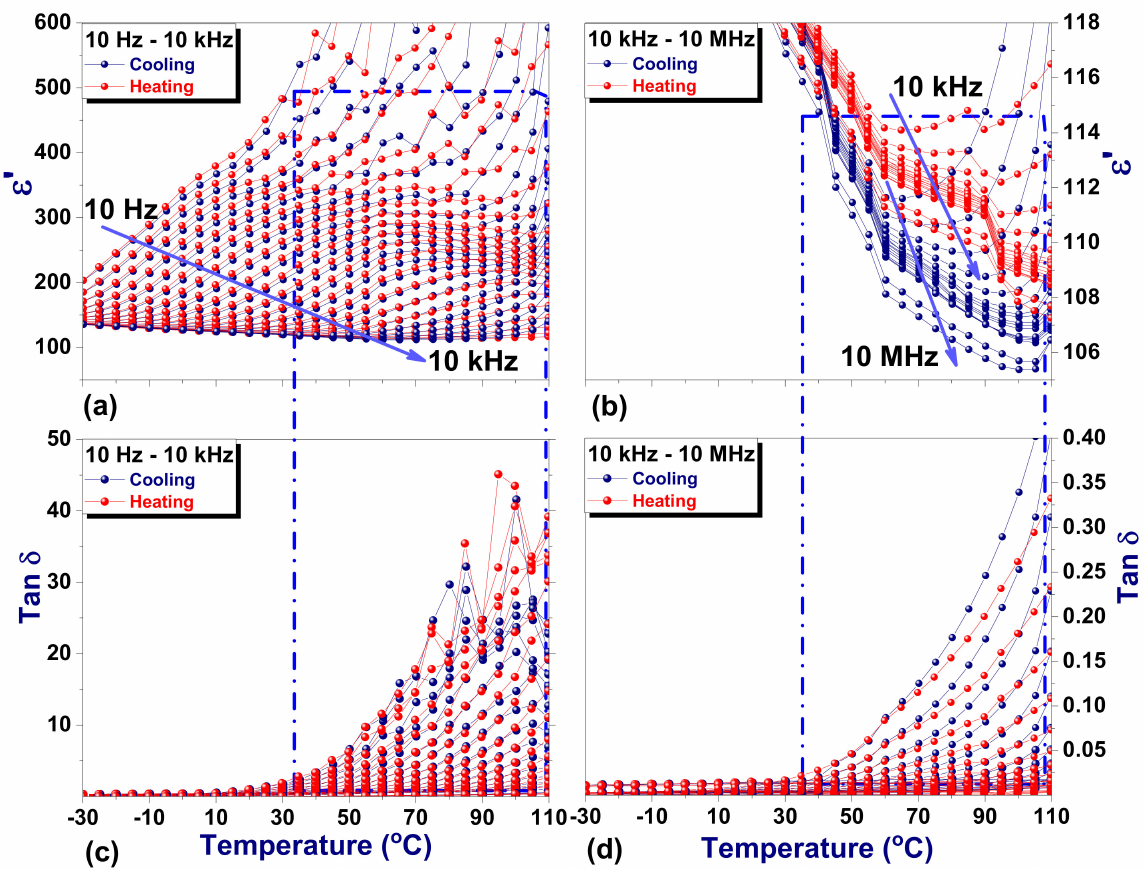
Figure 6. The temperature variation of ε ’ at different frequency intervals: ( a ) 10 Hz–1 kHz; ( b ) 10 kHz–10 MHz and similarly tan δ at different frequency intervals: ( c ) 10 Hz–1 kHz; ( d ) 10 kHz–10